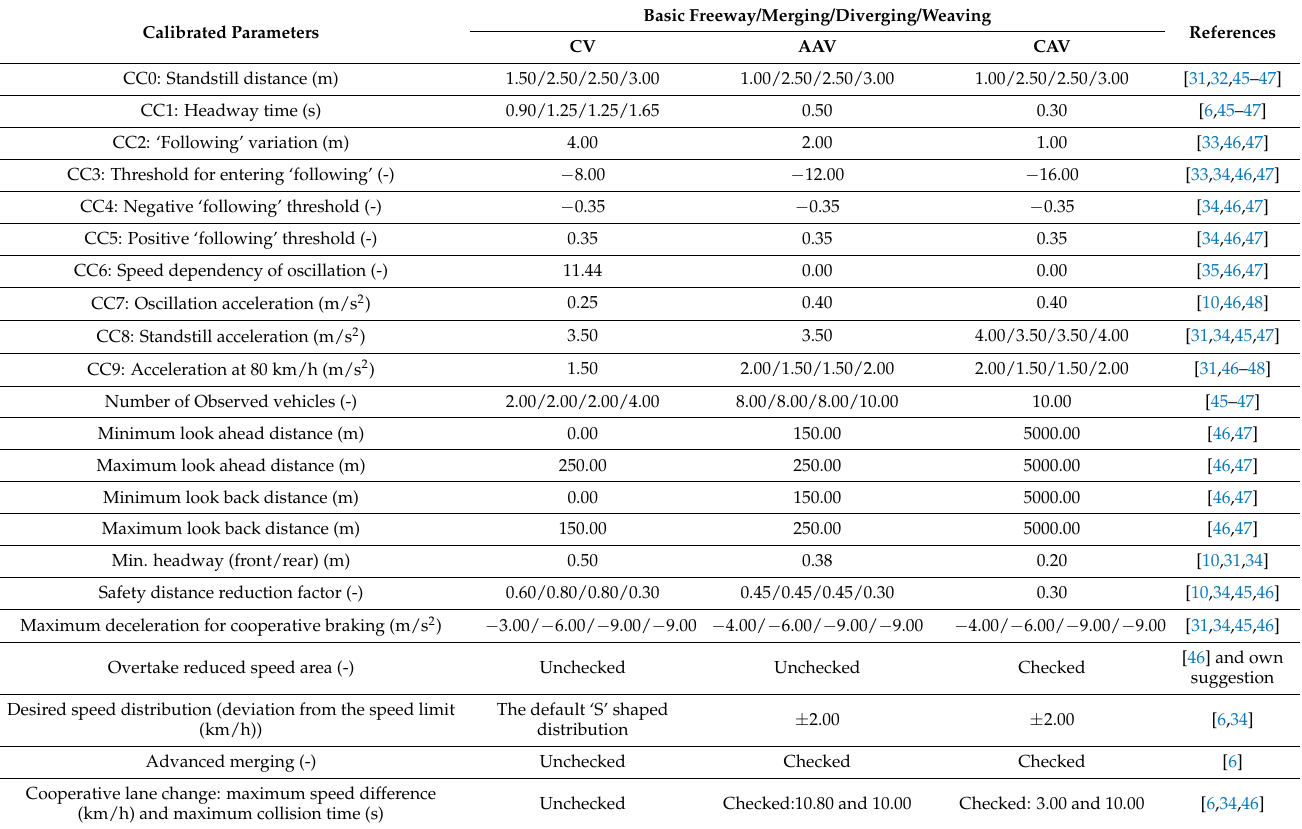
Table 1. Calibrated simulation parameters in VISSIM